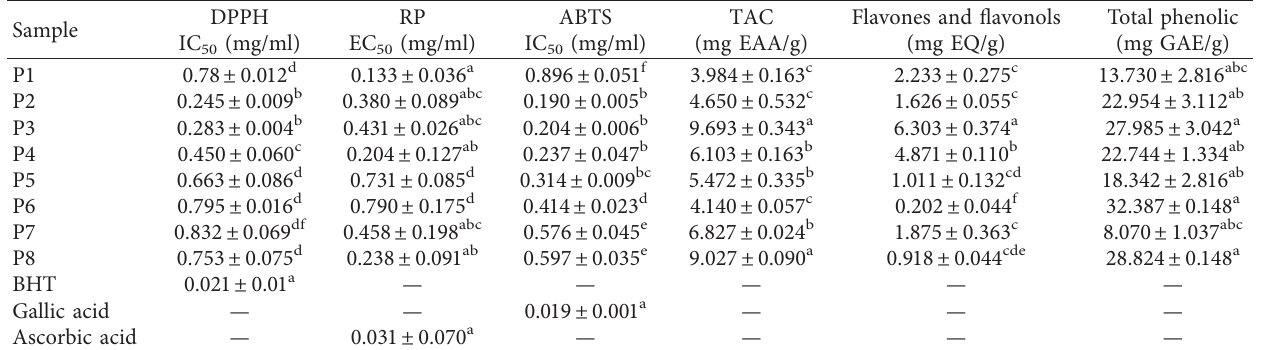
Table 5: The antioxidant content and activities of the ethanolic extract of monofloral bee pollens. Sample